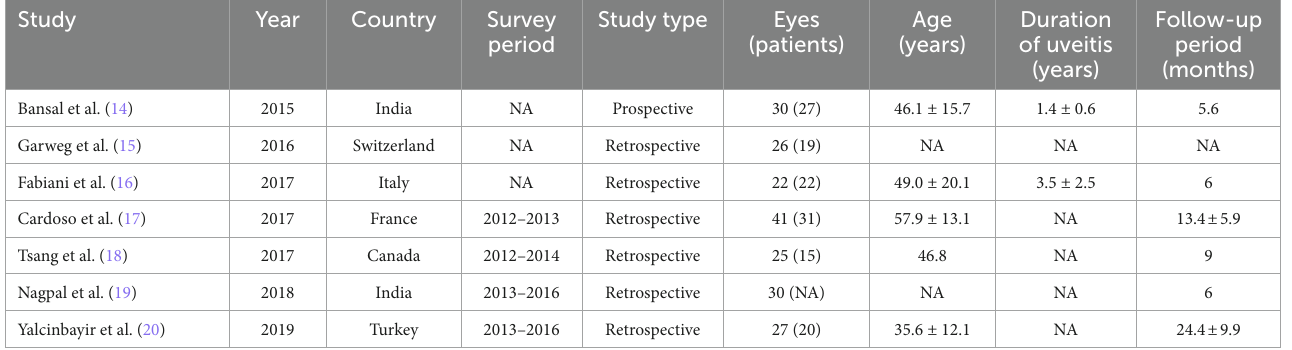
TABLE 1 Clinical demographics of included studies.